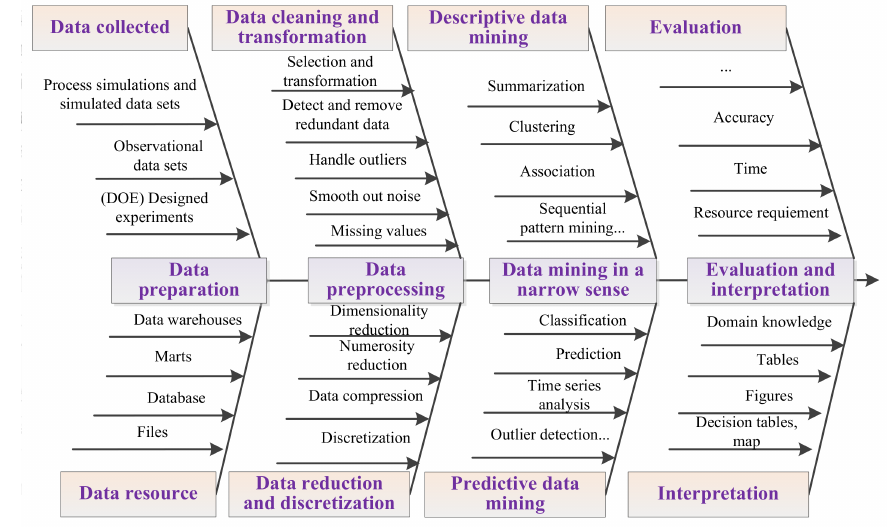
Figure 1. The data mining